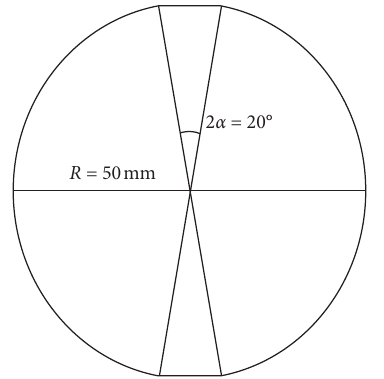
Figure 4: Schematic diagram of the split specimen.